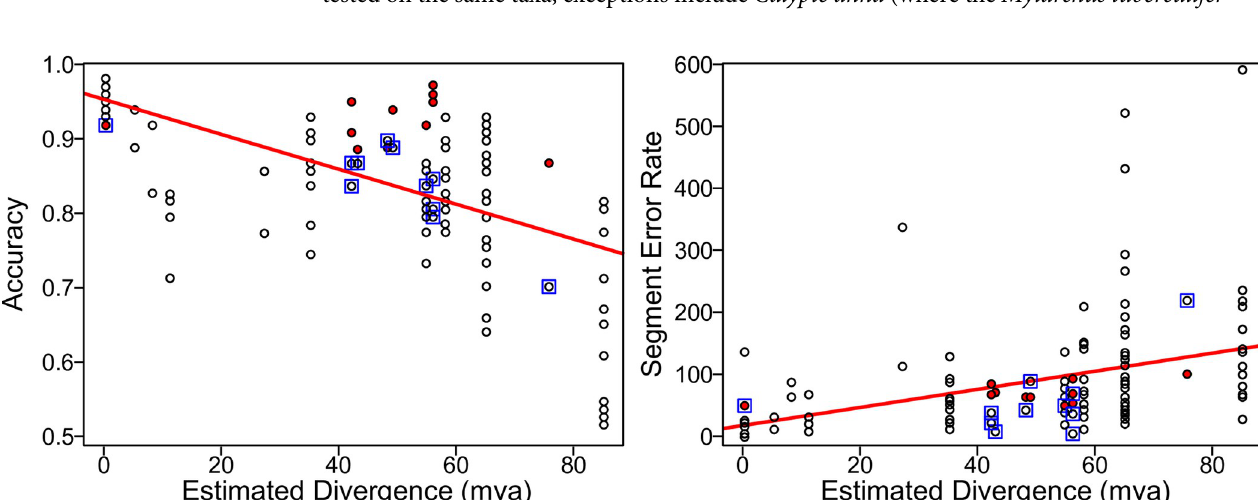
Fig 4. Frame rate accuracy and syllable error rate of models trained in TweetyNet across species. Far left shows phylogeny from Fig 1 with species at tips. Left: frame rate accuracy between species trained on (top to bottom) and species tested on (left to right). Species given with same symbols as in Fig 1 plus all nine species (circular cluster). For accuracy, darker values indicate higher accuracy. Right: segment error rate between species trained on and tested on. For segment error rate, darker values indicate higher error (worse performance) on a log scale, where 0 = 0% error and 263 = 263% error. Models tested on Myiarchus tuberculifer and Calypte anna have significantly higher error rates than all other species (p = 5x10 -15 , df = 110, f = 13.3, sum squares = 551384, mean squares = 55138). Segment error rates were usually lowest when models were trained and tested on the same taxa; exceptions include Calypte anna (where the Myiarchus tuberculifer